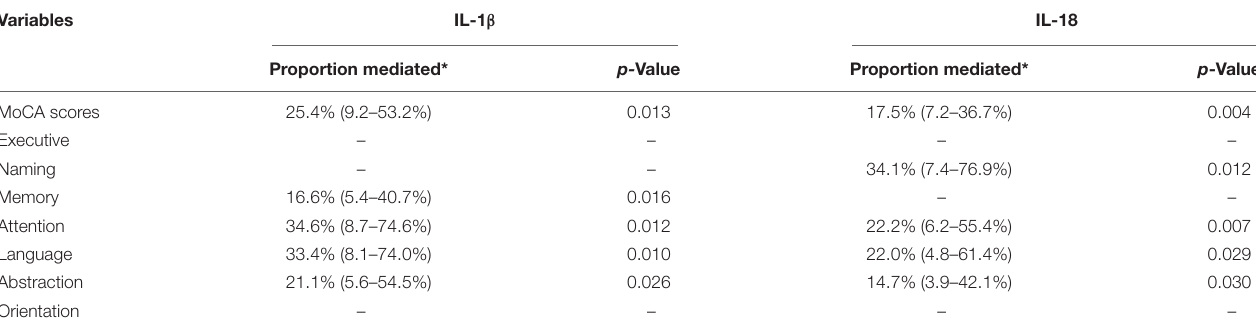
TABLE 5 | Logistic regression of the association between vitamin D (VD) deficiency and inflammatory factors in MCI group. Dependent variables